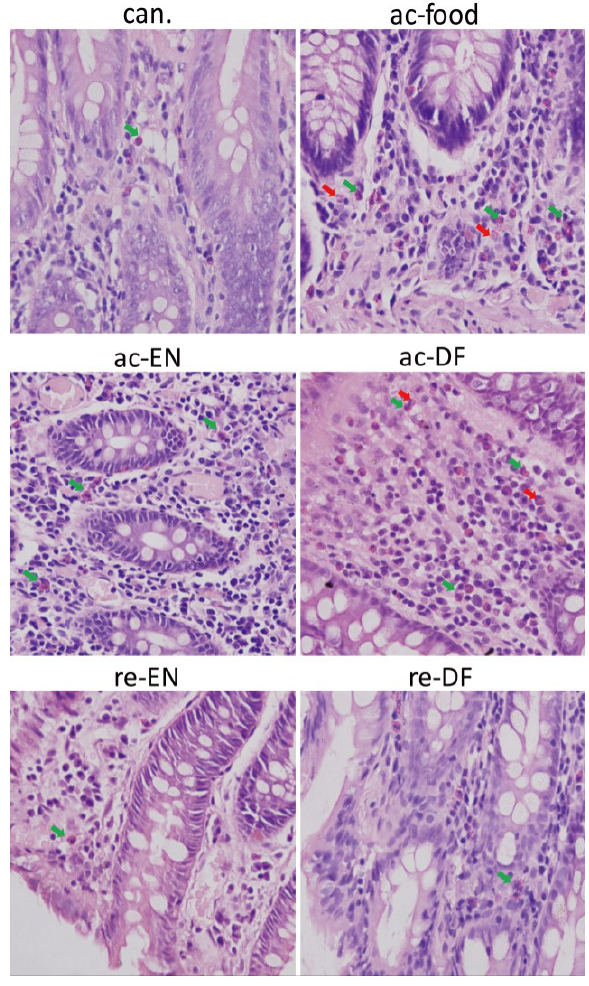
Figure 2. Eosinophils (green arrows) and neutrophils (red arrows) in the mucosae. Mucosae